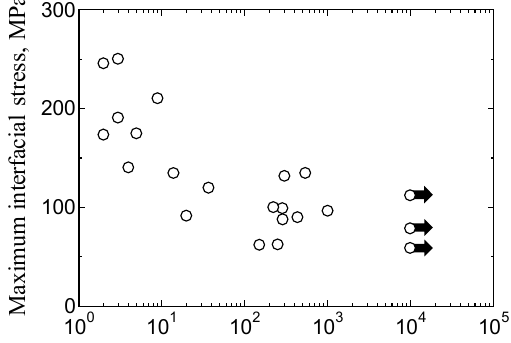
Figure 7. Relationship between maximum interfacial stress and the number of irradiation cycles required for delamination in LaSAT [18].